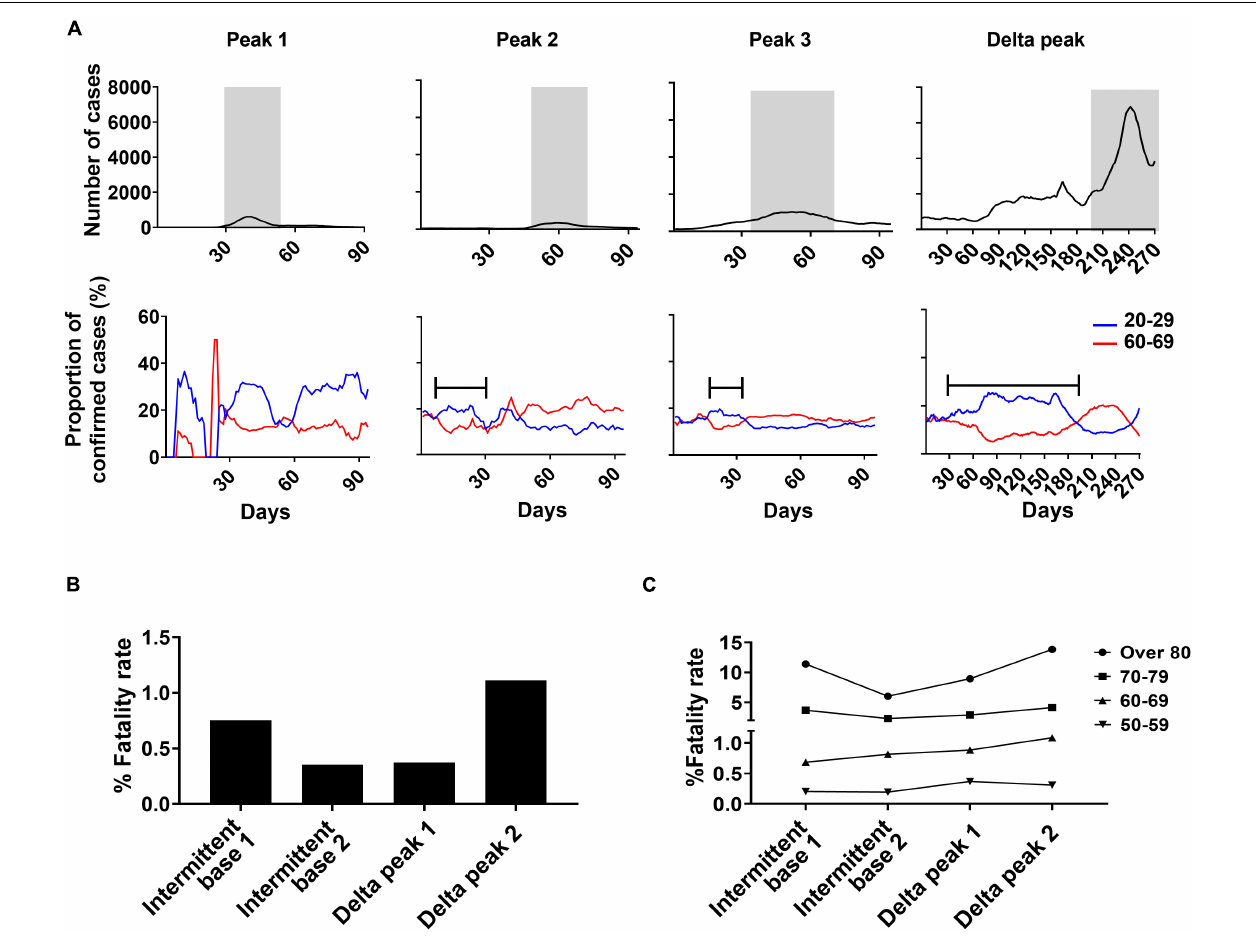
FIGURE 6 | Analysis of age shifts in primary SARS-CoV-2 infections and fatality rates. (A) Changing patterns of proportions of confirmed cases in the 20–29 and 60–69 years-old age groups during each peak in relationship to weekly confirmed cases of SARS-CoV-2. Gray indicates peak periods of confirmed cases. Bars indicate pre-peak period when the proportion of confirmed cases increased to 20% in Peaks 2 and 3 and 25% in the Delta peak. Total fatality rate (B) and fatality rate by age group (C) for specified